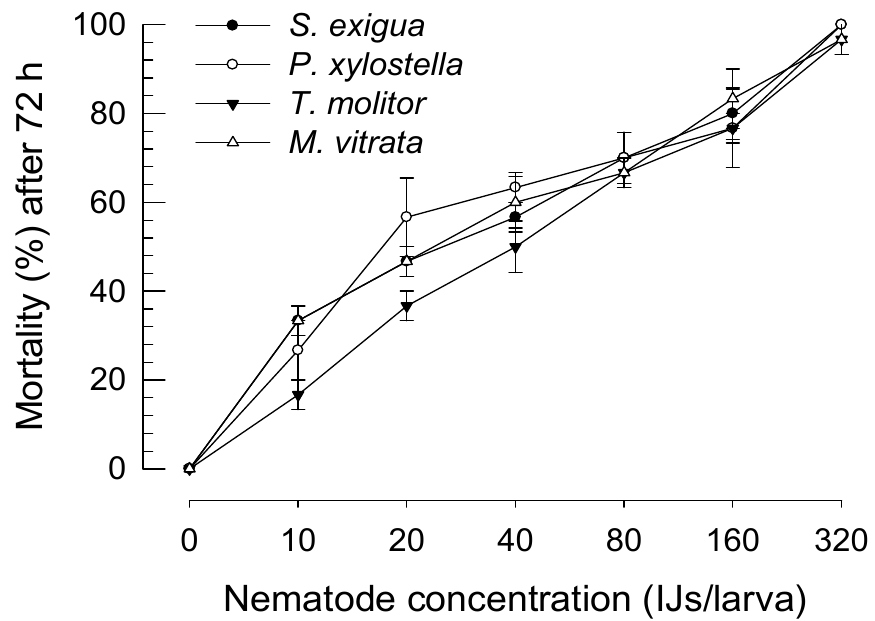
Figure 3. Virulence of S. feltiae K1 to larvae of four target insects: S. exigua, T. molitor, Maruca vitrata , and P. xylostella . Infective juveniles (IJs) at di ff erent concentrations were applied to a filter paper in a Petri dish (9 cm in diameter, 3 cm in height) containing 10 larvae of target insects. Each treatment was replicated three times. Nematode dose was calculated by dividing the applied IJ number by 10 larvae to get IJs per larva. Mortality was recorded at 72 h after IJ treatment. Dead insects were dissected to determine whether the lethality was due to the nematode infection. Table 3. Insecticidal activities of S. feltiae K1 against four di ff erent insect species. Third instar larvae of three lepidopteran species were used in bioassays. Larvae of a coleopteran species, T. molitor , with body length of approximately 2 cm were used in bioassays. To estimate the median lethal concentrations (LC 50 s), test nematode concentrations were 0, 10, 20, 40, 80, 160, and 320 IJs per larva. An experimental unit ( = each Petri dish) contained 10 larvae. It was replicated three times per nematode concentration. Median lethal times (LT 50 s) were estimated as nematode concentration of 80 IJs per larva.